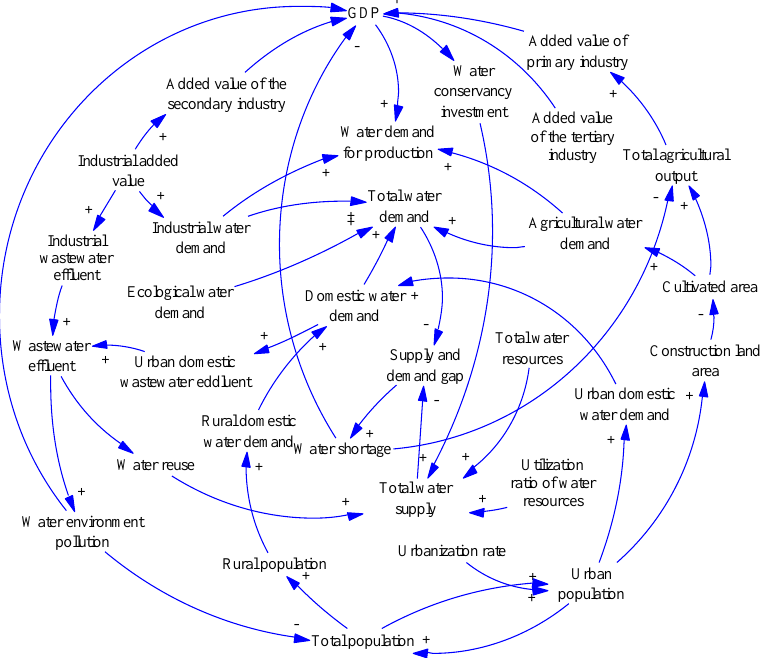
Figure 2. Causal loop diagram of water resources and urbanization development. Direct influences of key variables are shown as solid arrows; ‘ + ’ indicates a positive link; ‘ − ’ indicates a negative link. As shown in Figure 2, the positive ( + ) or negative ( − ) impact of a variable on another variable is indicated by the solid arrow. The variables are directly connected to each other by links, generating positive and negative feedback loops. The positive feedback loops indicate a reinforcing change within the water resources and urbanization development system. The negative feedback loops indicate a depressed and balancing process. In this concept model, the main loops of cause and effect are as follows.